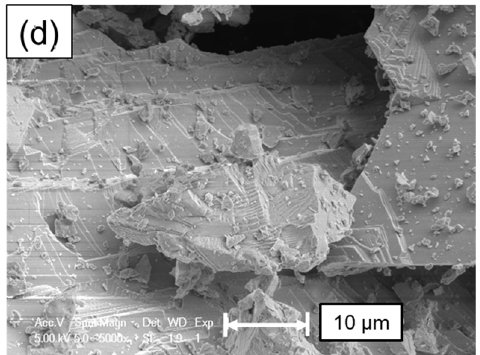
Figure 1. Secondary electron images taken by scanning electron microscope (SEM) of cadmium telluride CdTe powders: ( a ) CdTe 250 with grain sizes d 250 < 250 µm and ( b ) CdTe 840 with grain sizes d 840 < 840 µm. Due to sieving, the powder contains also smaller sized grains: ( c ) CdTe 250 with grain sizes d 250 < 250 µm and ( d ) CdTe 840 with grain sizes d 840 < 840 µm with higher resolution.